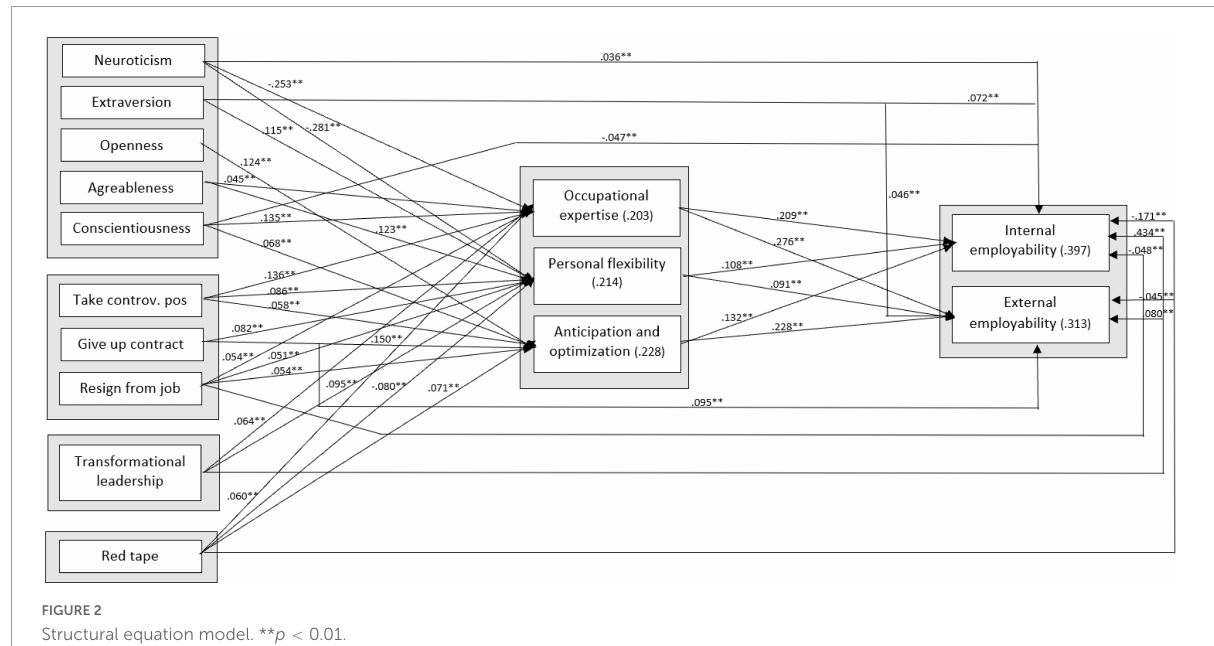
FIGURE2 Structural equation model. ** p < 0.01.